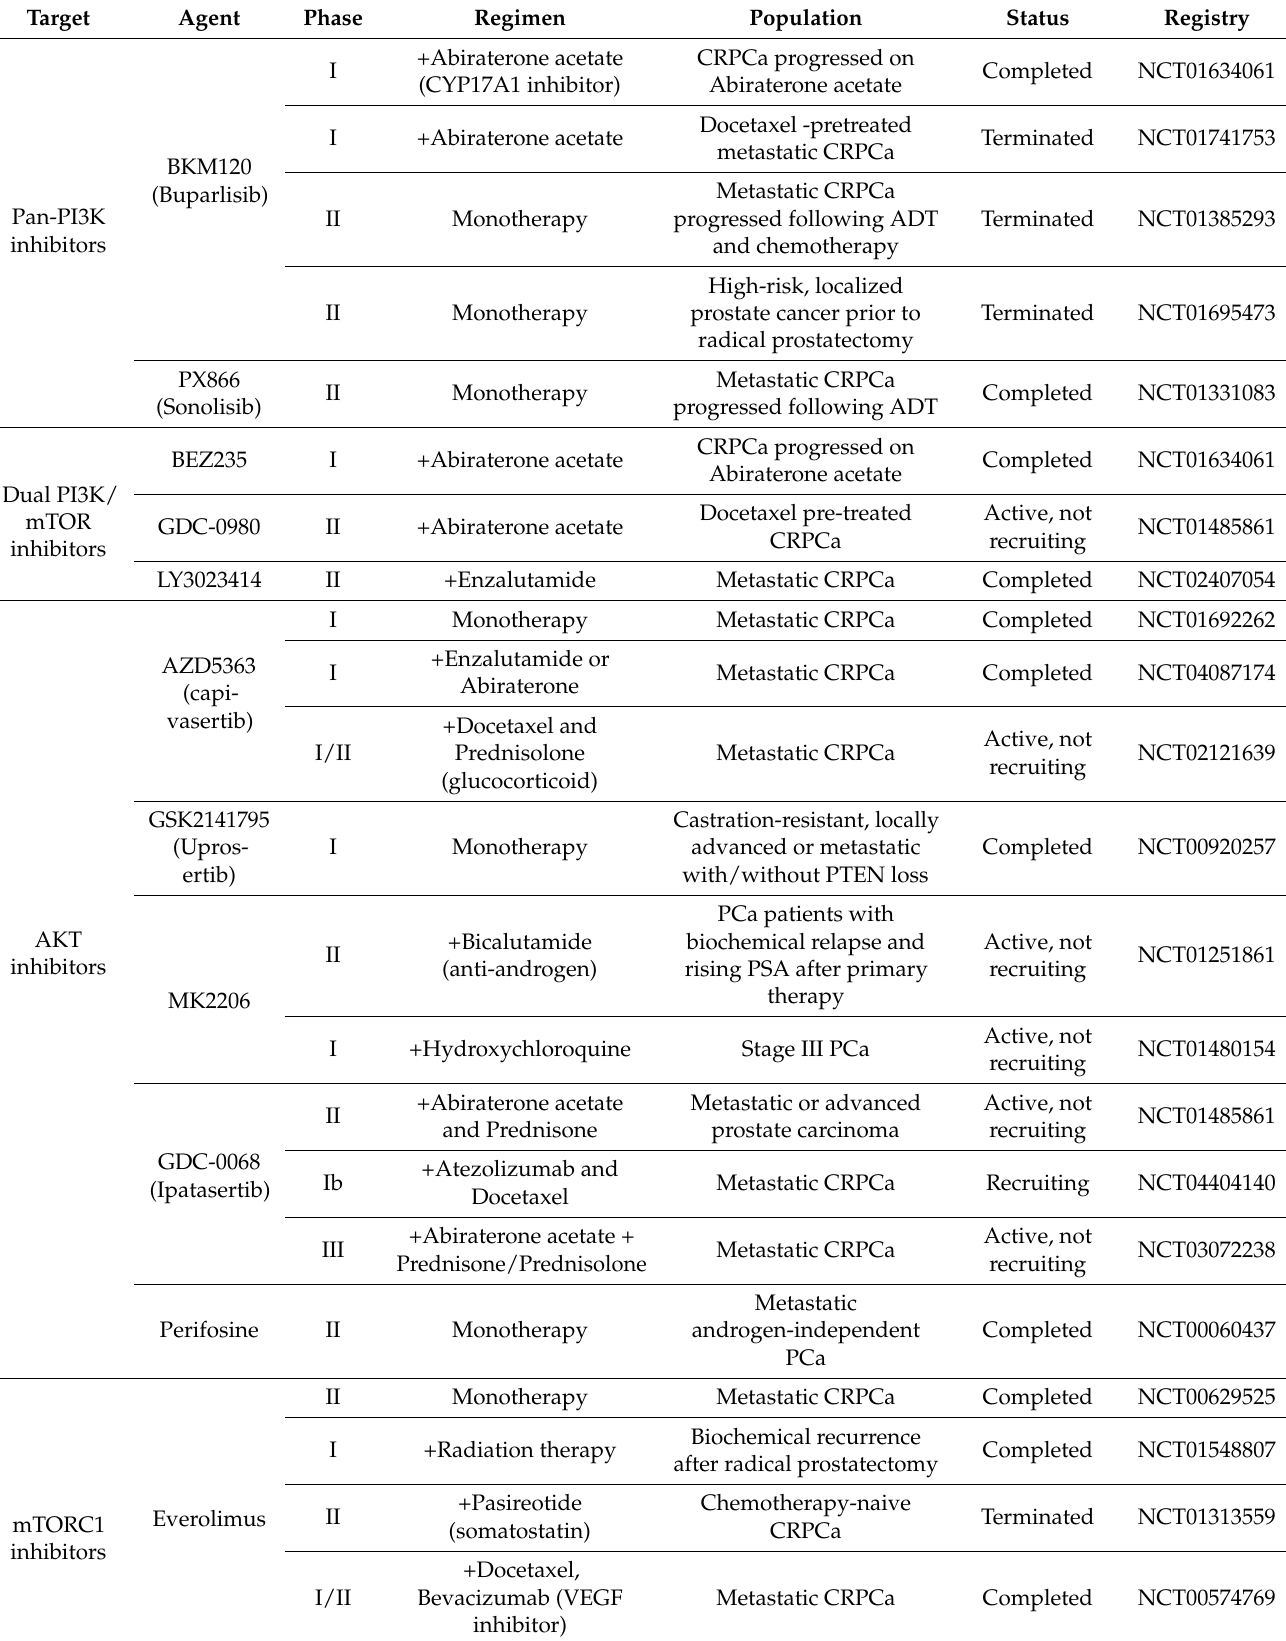
Table 1. PI3K-AKT-mTOR pathway inhibitors used in clinical